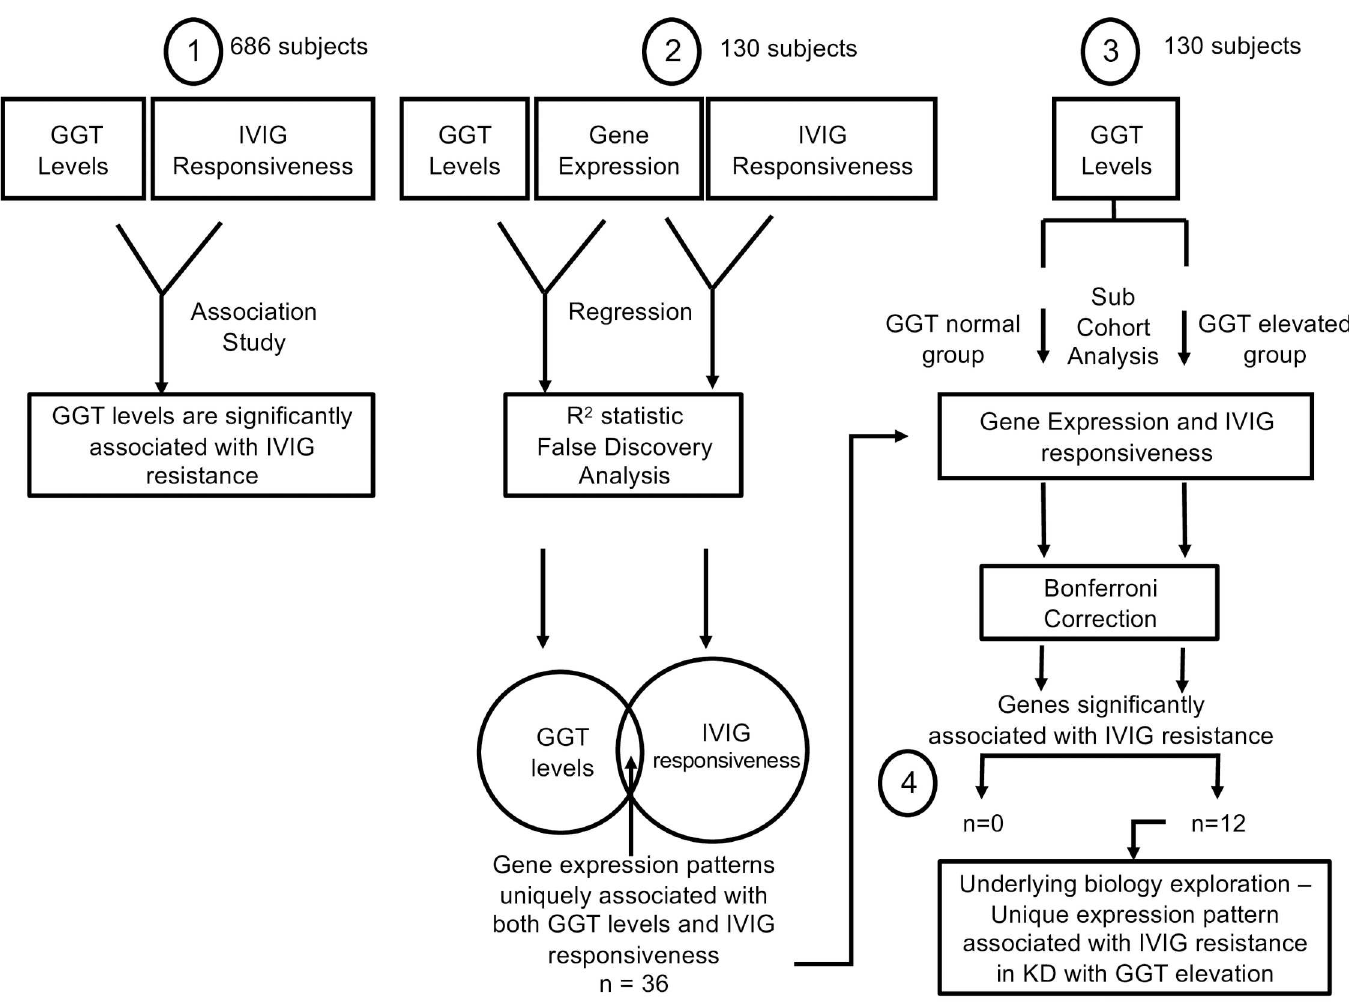
Fig 1. Study outline of analyses to uncover unique gene expression patterns underlying IVIG responsiveness in subjects with elevated serum GGT levels. (1) Analysis of GGT levels with IVIG responsive-ness; (2) Global gene expression analysisby R2 statistic and FDR anal-ysesto identify genes, explainingvariations in both IVIG responsiveness and GGT elevation;(3) Targeted analysisof the step 2 discoveredgenes in either GGT normal or elevated subgroupsto reveal gene expressionpatterns specific for each sub-group of subjects; (4) Pathway and literatureanalysisto explore the underlyingbiologyof IVIG resistancein subjects with GGT